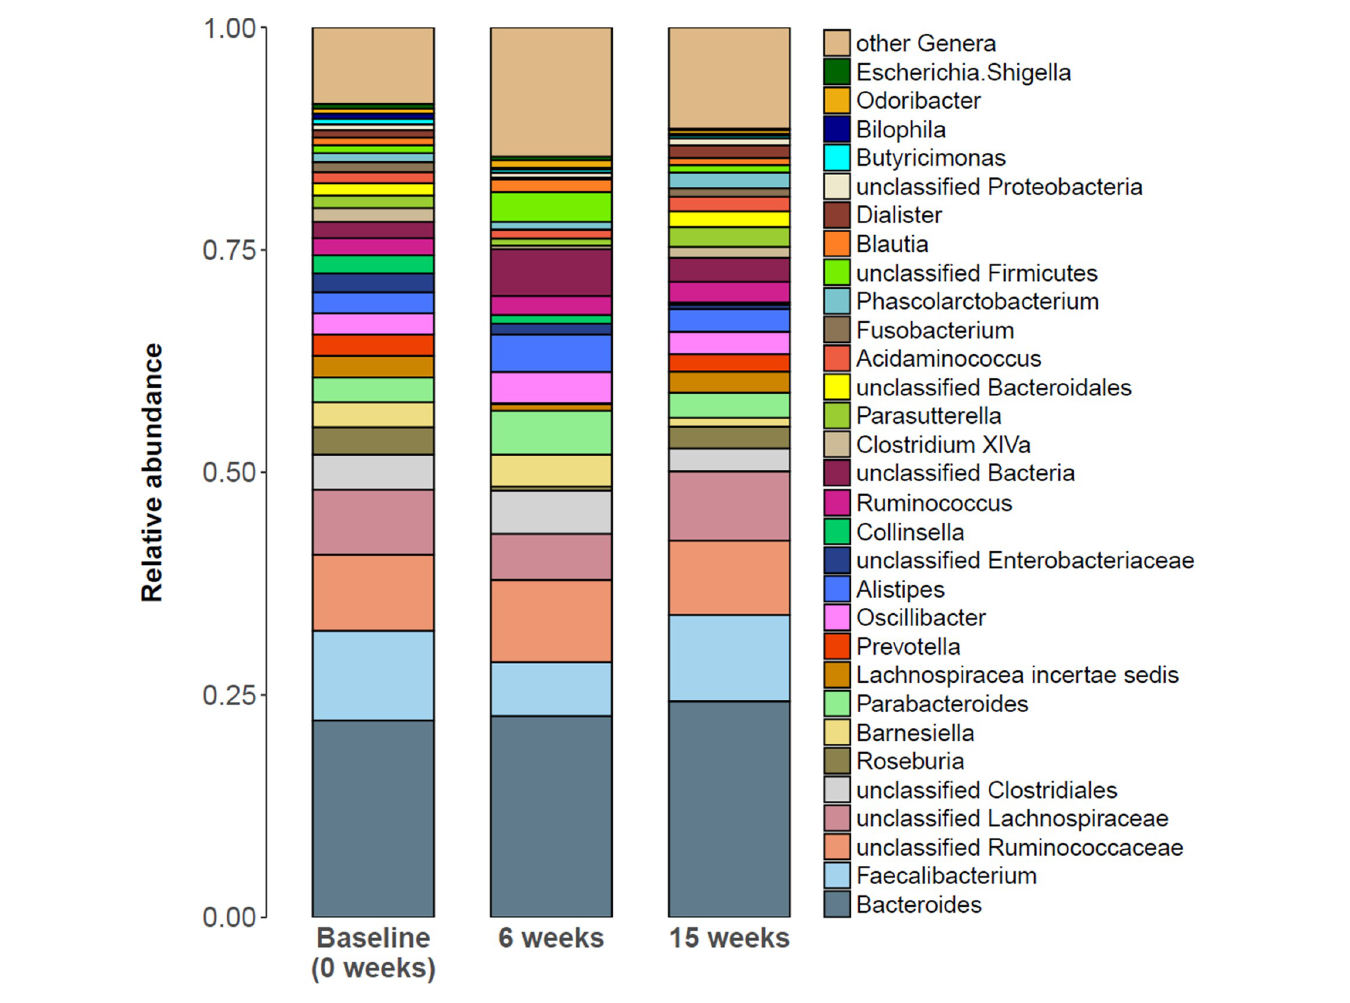
Fig 4. Taxon composition at baseline, 6 and 15 weeks after study launch. Stacked bar plots portraying the average sample composition of the study group (n = 12) at baseline/0 weeks, after six weeks of low-calorie formula diet and after regular food reintroduction at fifteen weeks. Taxon abundance changes were most prominent at six weeks, but mostly not sustained at fifteen